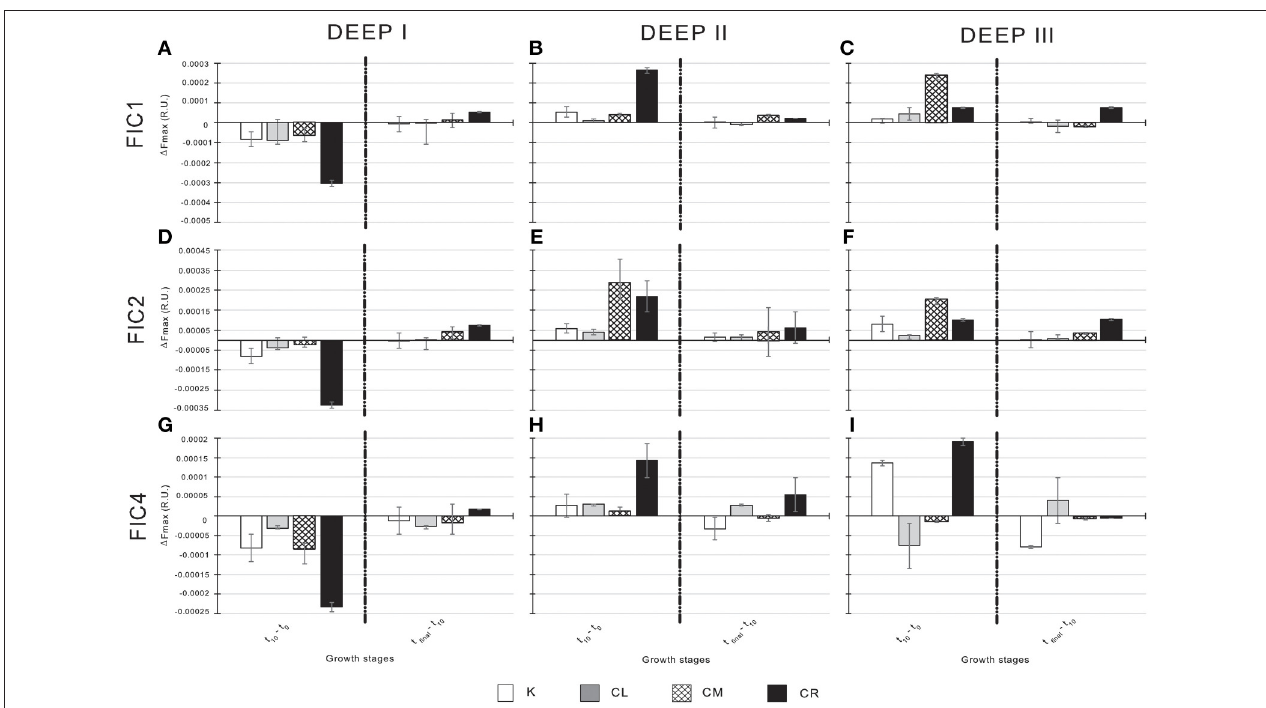
FIGURE 5 | Variations of each humic-like component in the four experimental conditions of the three experiments. From top to bottom: variations of FIC1 for DEEP I (A) , DEEP II (B) and DEEP III (C) ; variations of FIC2 for DEEP I (D) , DEEP II (E) and DEEP III (F) ; and variations of FIC4 for DEEP I (G) , DEEP II (H) and DEEP III (I) . Exponential-growth and stationary phases are separated in the graphs. Values expressed in